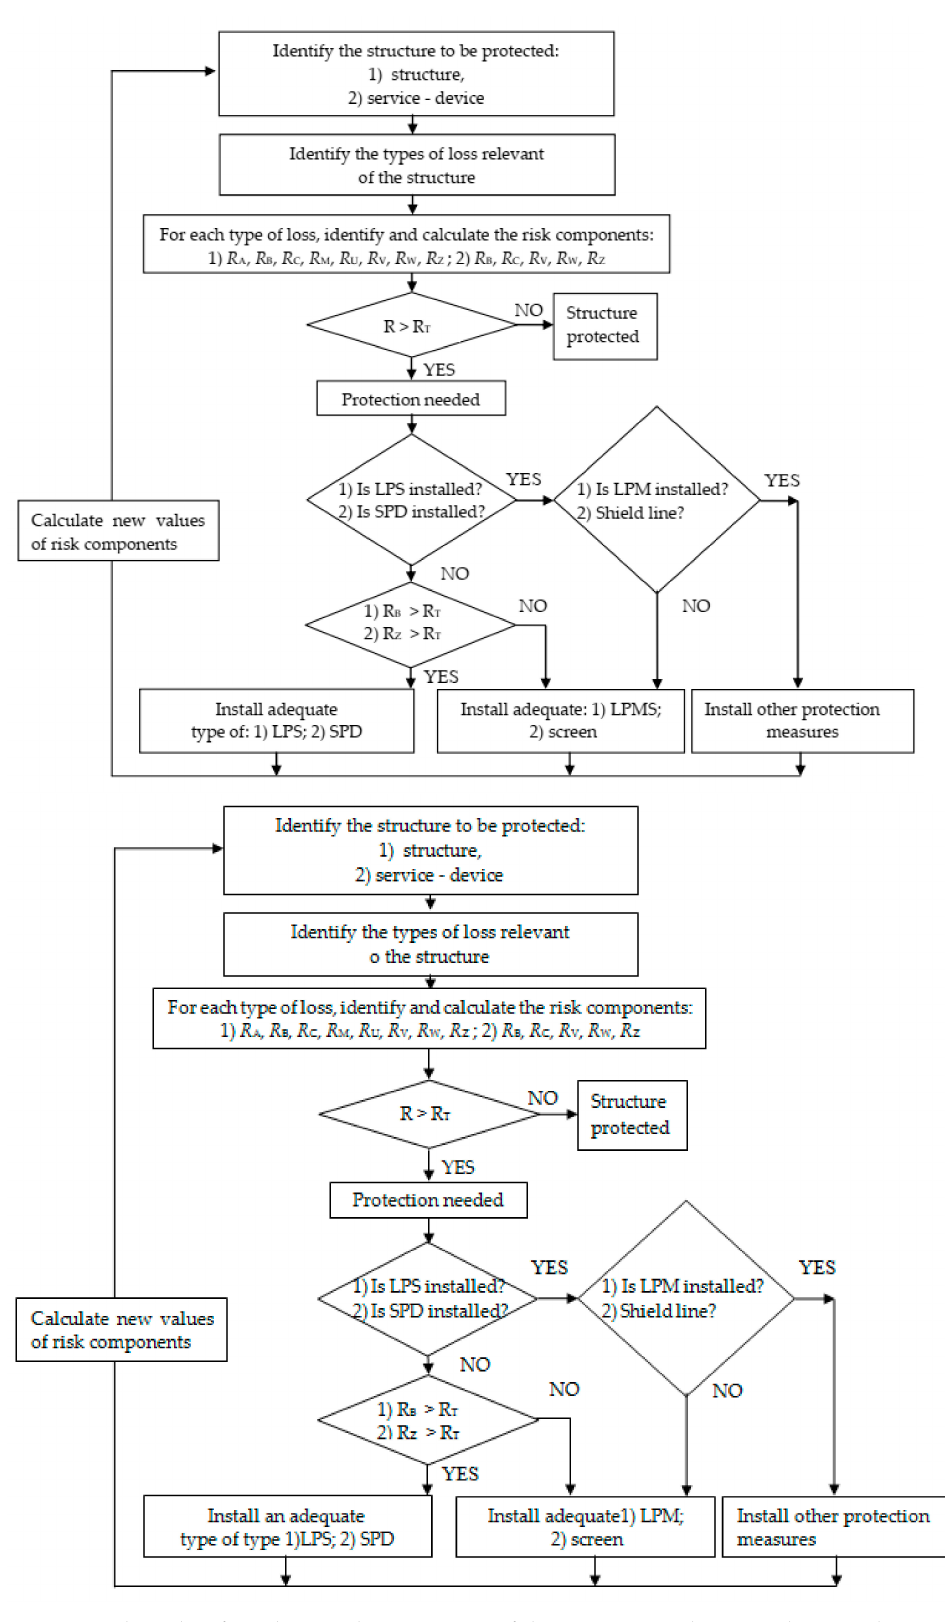
Figure 1. Algorithm for selecting the protection of the structure and service device, where: SPD - Surge Protective Device,